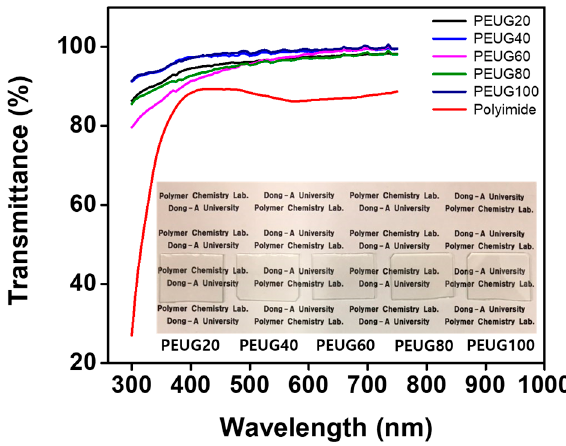
Figure 3. Optical transmittance spectra of eugenol modified polystyrene (PEUG#) and polyimide orientation layers onto quartz substrates.